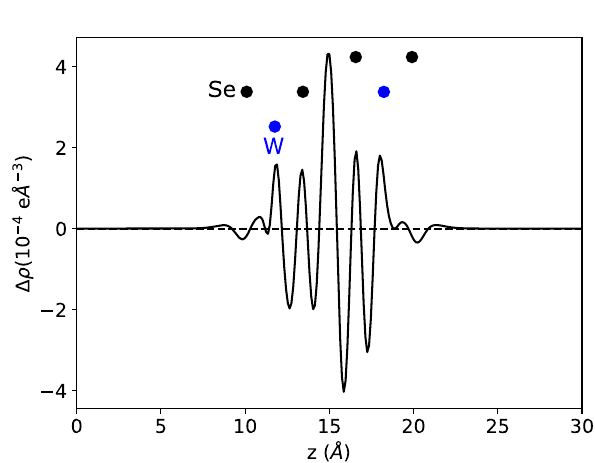
Figure 4. Difference between plane-averaged charge density of an XM ′ bilayer and two isolated monolayers, showing greatest charge transfer in interlayer region between planes of Se atoms. Dashed line is a guide to the eye, showing �ρ = 0